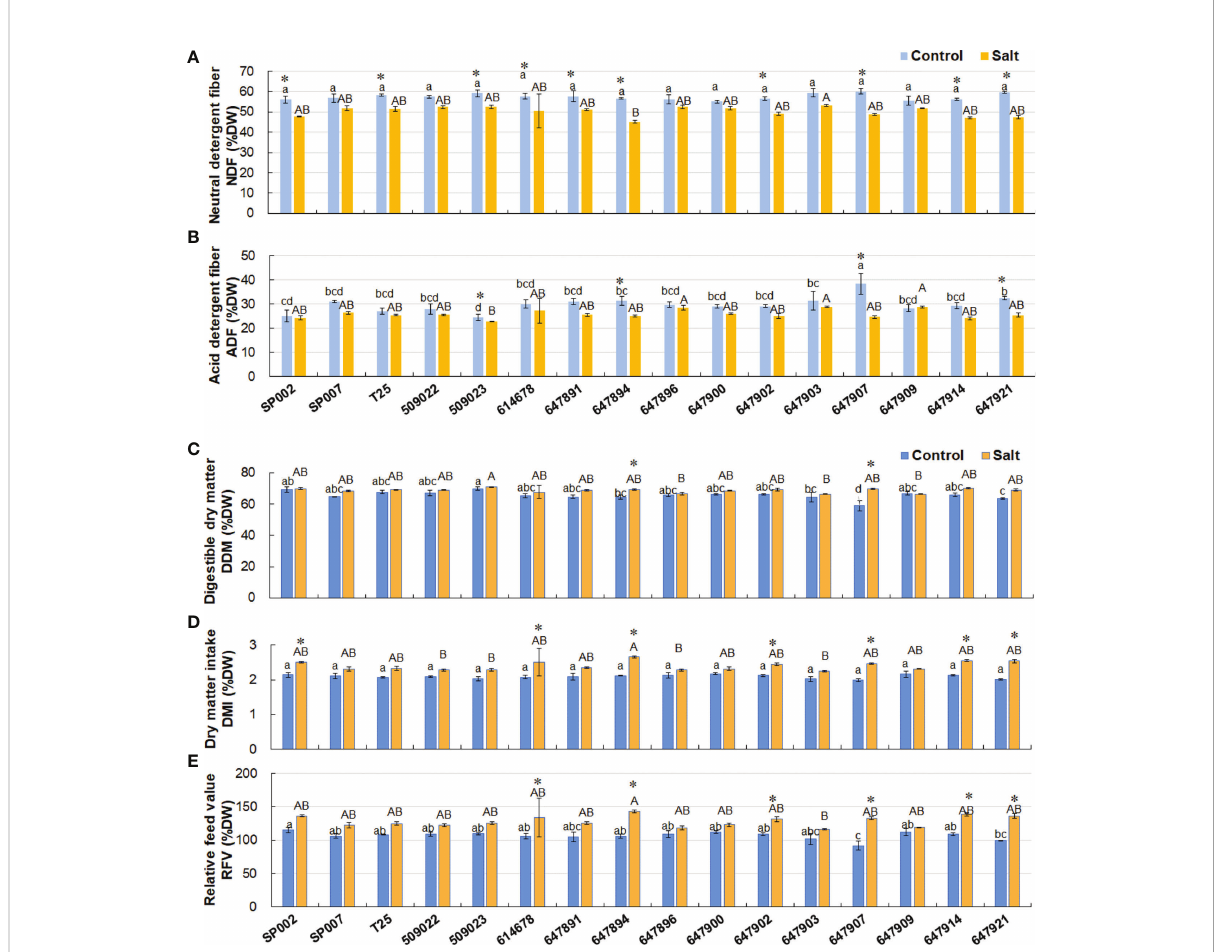
FIGURE 6 Effect of salt stress on forage nutritive value of 16 seashore paspalum ecotypes. The neutral detergent fi ber NDF (% DW) (A) and acid detergent fi ber ADF (% DW) (B) were measured before treatment (control) and after NaCl treatment for 10 d (salt); then digestible dry matter, DDM (% DW) (C) , dry-matter intake, DMI (% DW) (D) , and relative feed value (RFV) (E) were determined. Means of three independent experiments and standard errors are presented; the same letter above the column indicates no signi fi cant difference at P <0.05. Lowercase letters and uppercase letters respectively indicate signi fi cant comparisons among different ecotypes in the control group and treatment group. * indicates signi fi cant difference at P <0.05 by T-test between salt treatment and control for 16